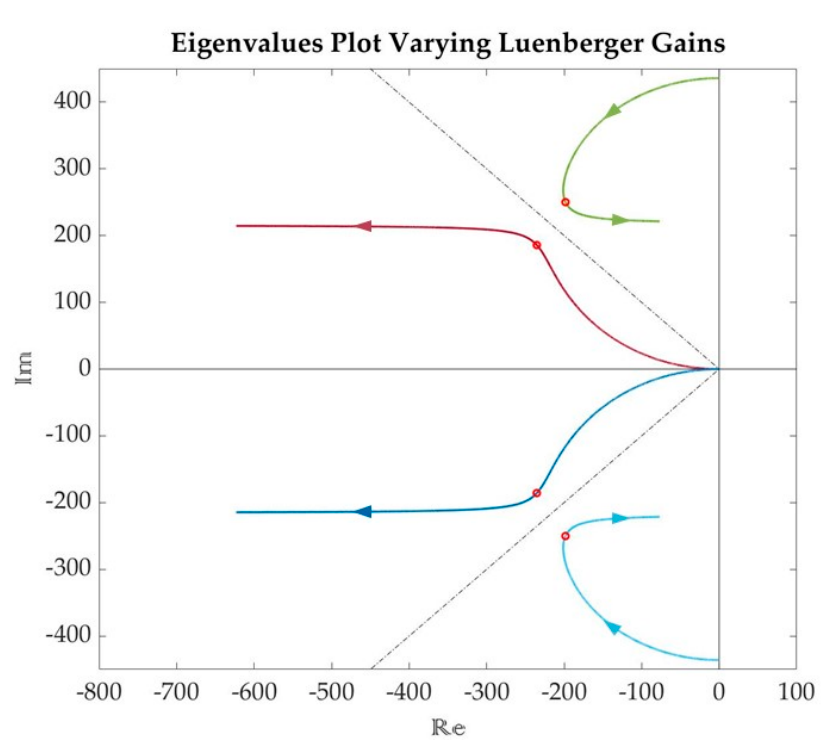
Figure 3. Eigenvalues plot varying observer gains.